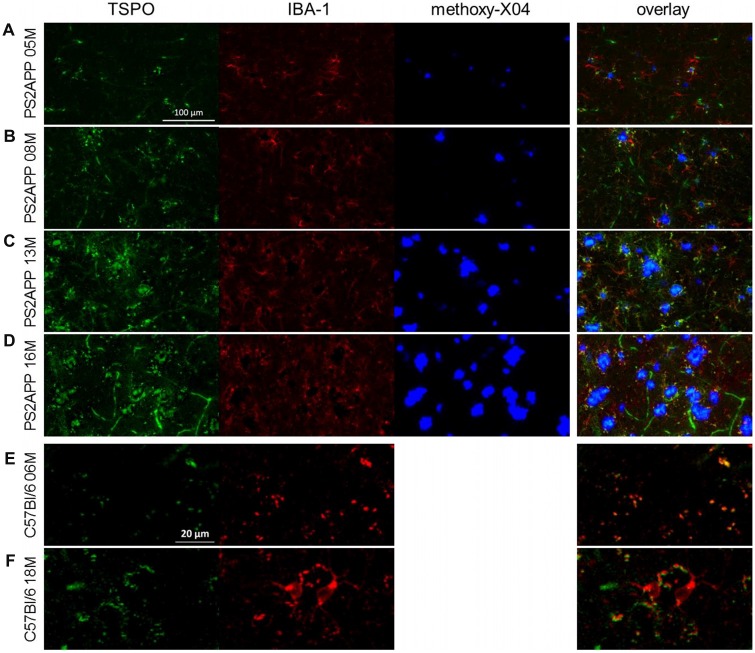
Immunohistochemistry confirms μPET findings. (A–D) Immunohistochemistry in the frontal cortex of PS2APP and WT mice at different ages. TSPO staining is depicted in green. IBA-1 positive cells are illustrated in red. Fibrillar Aβ plaques stained by methoxy-X04 are shown in blue. Scale bar in (A) indicates 100 μm. (E,F) Immunohistochemistry in the frontal cortex of WT mice at different ages. TSPO staining is depicted in green. IBA-1 positive cells are illustrated in red. Please note that anti-TSPO recognizes an antigen in blood vessels a phenomenon that is well described in the literature. Therefore a higher zoom was used for a proper visualization of increasing IBA-1 positive microglia in aged WT. Scale bar in (E) indicates 20 μm.